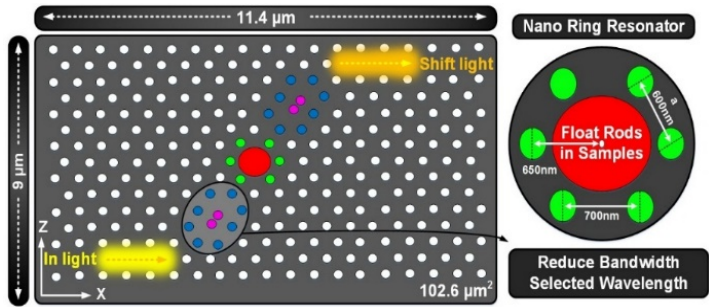
Figure 2. The new structure of an all-optical reflective index biosensor.